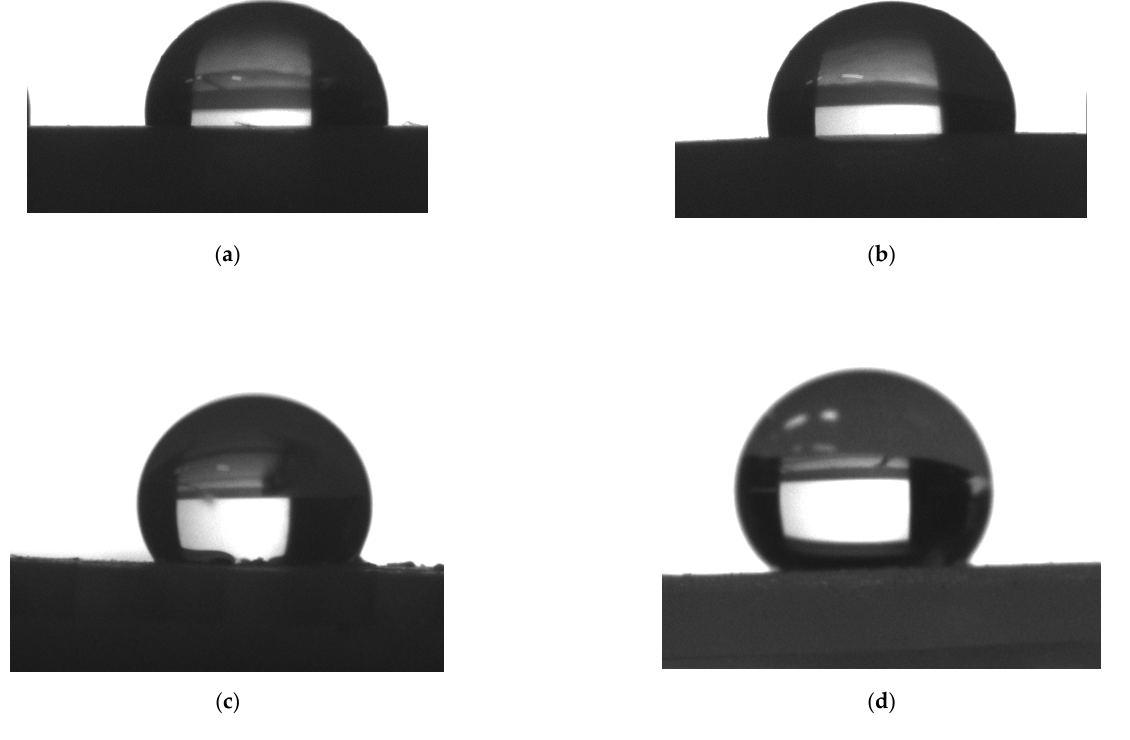
Figure 9. Schematic arrangement of the water droplet on ( a ) smooth, non-modified surface (S), ( b ) smooth, laser-modified surface (S-C1-L6), ( c ) surface geometrised during production (G), ( d ) hier- archic structure produced through laser modification (G-C1-L6). Table 4. Results of contact angle measurements [ ◦ ] for smooth and geometrised samples, non- modified and subjected to chemical modification.